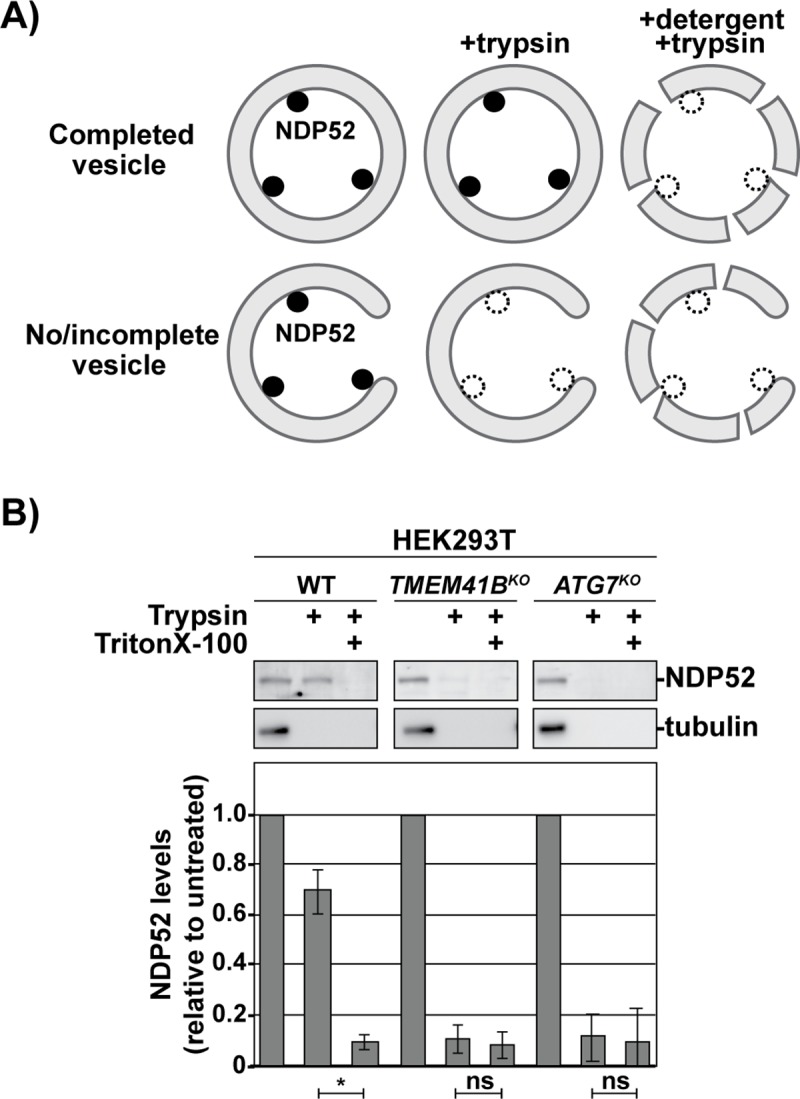
TMEM41B is required for phagophore maturation.(A) Schematic of the protease protection assay for detecting closed autophagosomes. Targets are protected from proteolysis by trypsin when sequestered by properly sealed vesicles. (B) WT and indicated HEK293T knockouts were treated for 18 h with 100 nM BafA1 prior to gentle, mechanical lysis. The corresponding cell extracts were treated as indicated prior to being resolved by SDS-PAGE and analyzed by IB with indicated antibodies. NDP52 serves as a representative autophagy target; tubulin is unincorporated and serves as a control for proteolysis. Bar graphs show the mean ± SD of each sample from 3 independent experiments; p-values were determined using a student t test. *p < 0.01. Related to S4 Fig. Underlying data for all summary statistics can be found in S1 Data. BafA1, Bafilomycin A1; HEK, human embryonic kidney; IB, immunoblotting; NDP52, nuclear dot protein 52; ns, not significant; TMEM41B, transmembrane protein 41B; WT, wild type.